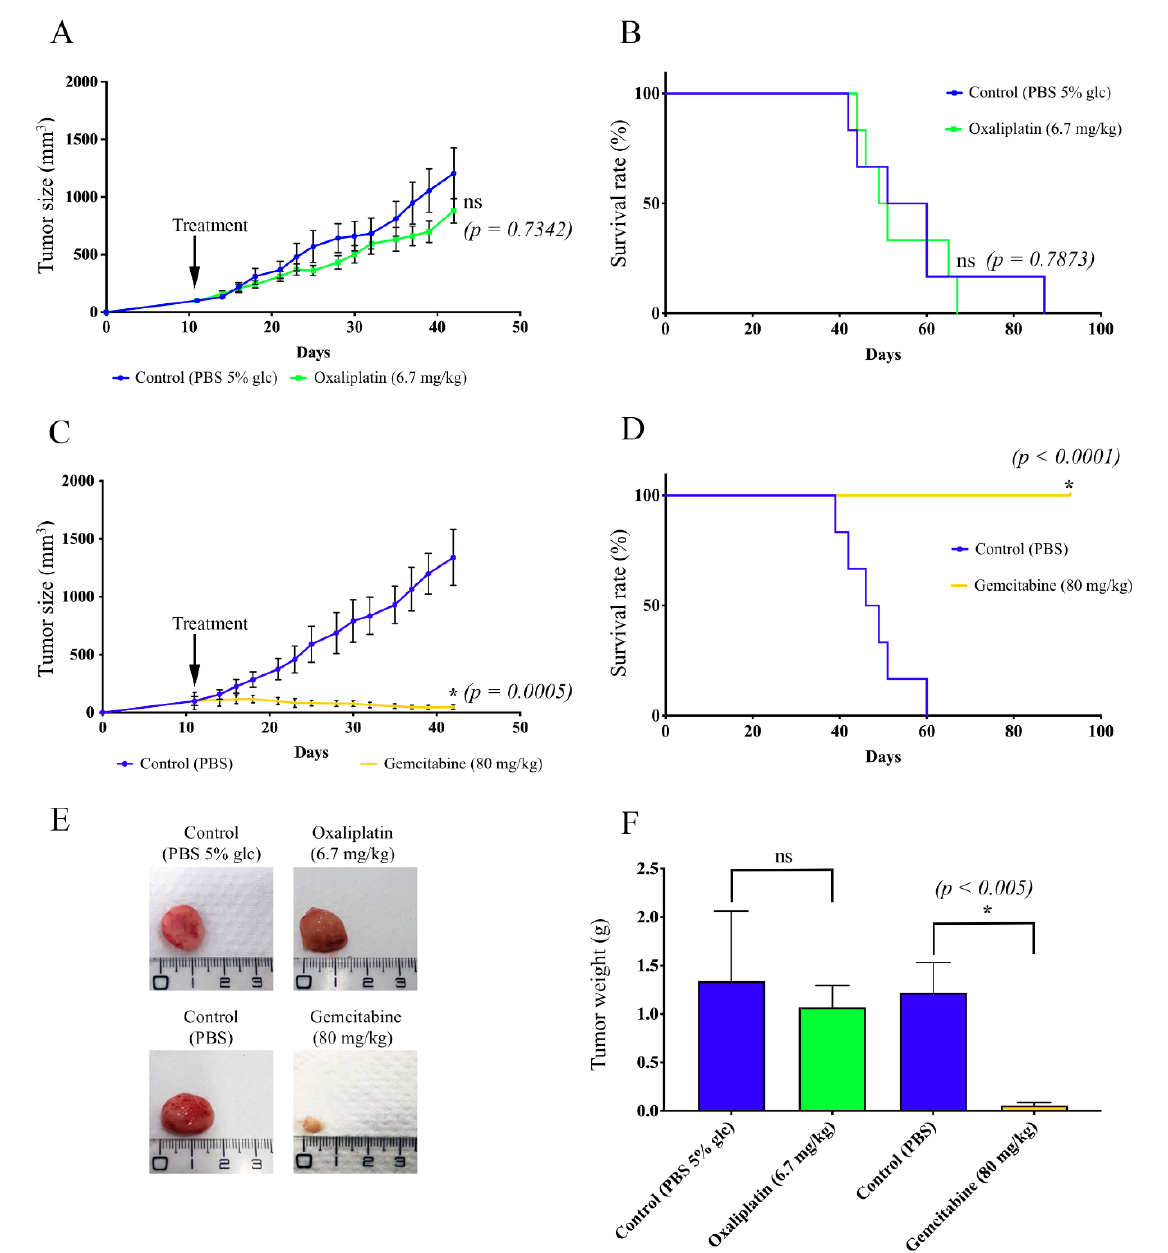
Figure 2. Study of the effects of gemcitabine on oxaliplatin-resistant colorectal cancer cells in vivo. Nude mice were inoculated with HT29-D4 Rox1 cells. After 11 days, the mice were treated with oxaliplatin (6.7 mg/kg), gemcitabine (80 mg/kg), PBS and 5% glucose (PBS 5% glc), or PBS. ( A ) Growth curves of the xenografted tumors for oxaliplatin and its control (PBS 5% glc). ( B ) Kaplan–Meier survival curves for oxaliplatin and its control. ( C ) Growth curves of the xenografted tumors for gemcitabine and its control (PBS). ( D ) Kaplan–Meier survival curves for gemcitabine and its control. ( E ) Representative pictures of the tumors after dissection. ( F ) Tumor weight comparison. Asterisks indicate statistical significance ( p values are indicated on the graphs), ns: not